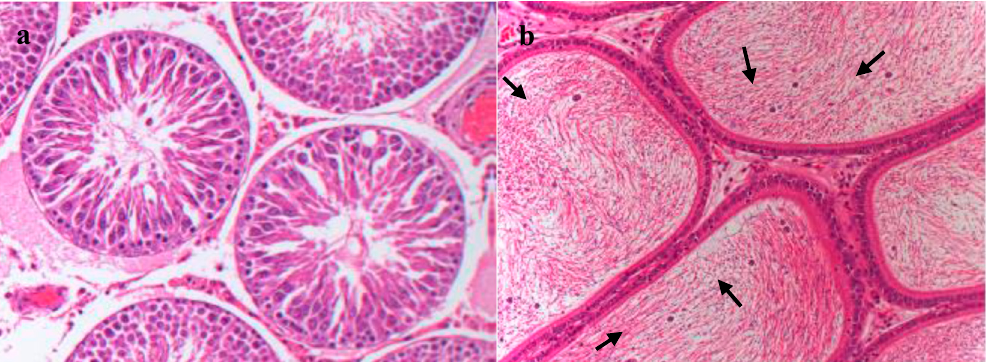
Figure 3. Histopathology of the testis and epididymis of rats treated with 10 mg/kg FLC for ninety days (at 200×magnification, H&E stain). ( a ) Testis. ( b ) Epididymis. Note: Black arrows represent cell debris.